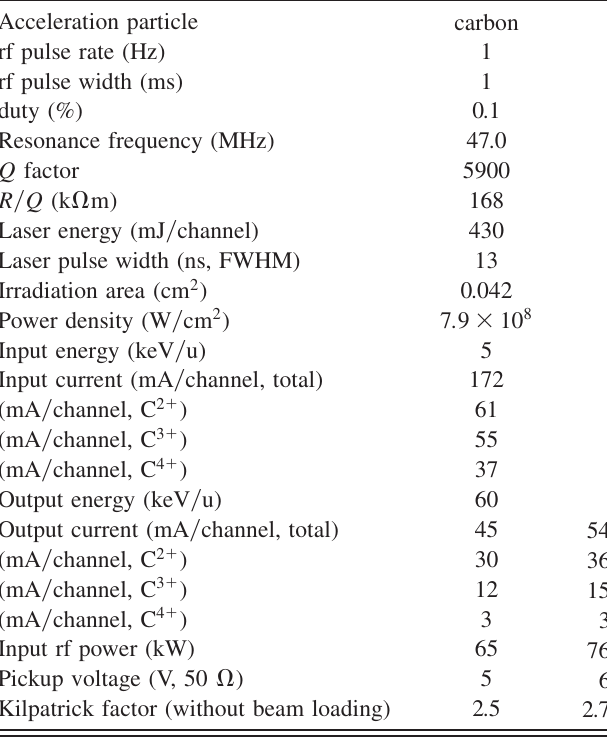
TABLE XV. Summary of the beam acceleration test